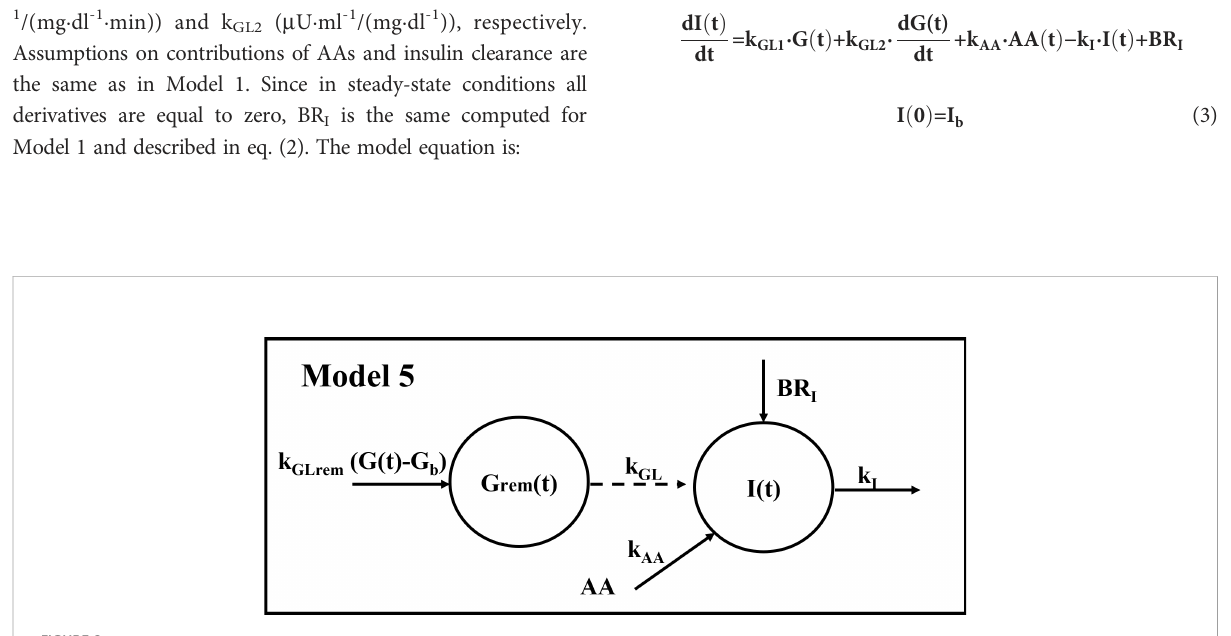
FIGURE 2 Compartmental representation of the double-compartment model. The model is composed by a compartment representing plasma insulin I(t) and a compartment representing glucose (suprabasal concentration) remote from plasma G rem (t). The input to the remote compartment is represented by suprabasal plasma glucose (G(t)-G b ), through the k GLrem parameter. G rem (t) acts as input through the k GL parameter; similarly, amino acids act as input through the k AA parameter; k I represents the insulin elimination rate from plasma and BR I is the basal insulin appearance rate due to factors other than glucose and amino acids.